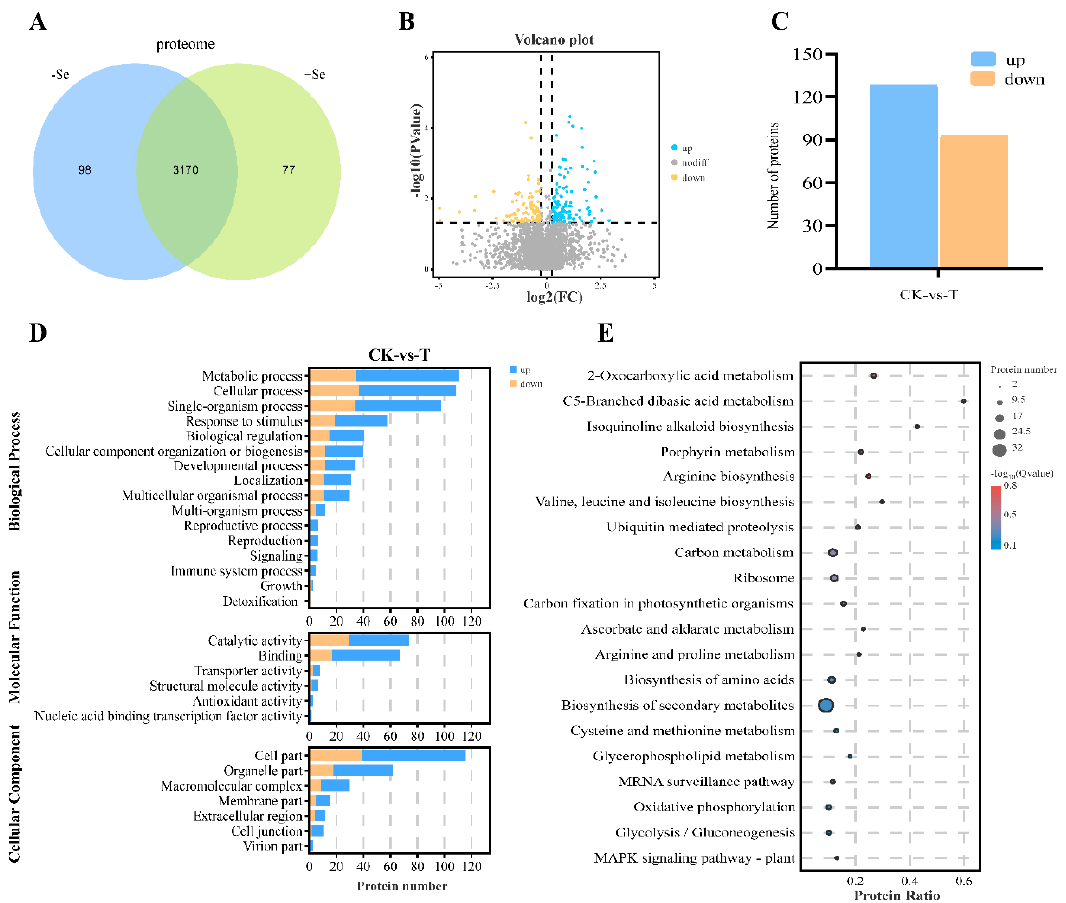
Figure 5. Analysis of the differentially expressed proteins (DEPs) in response to selenite treatments. ( A ) Venn diagram showing the overlap in the numbers of proteins between the Na 2 SeO 3 treatment and the control. ( B ) Volcano plot of DEPs under Na 2 SeO 3 stress. ( C ) D. salina DEPs under Na 2 SeO 3 stress. ( D ) The GO functional classifications of DEPs in response to Na 2 SeO 3 . ( E ) KEGG enrichment analysis of DEPs in response to Na 2 SeO 3 .